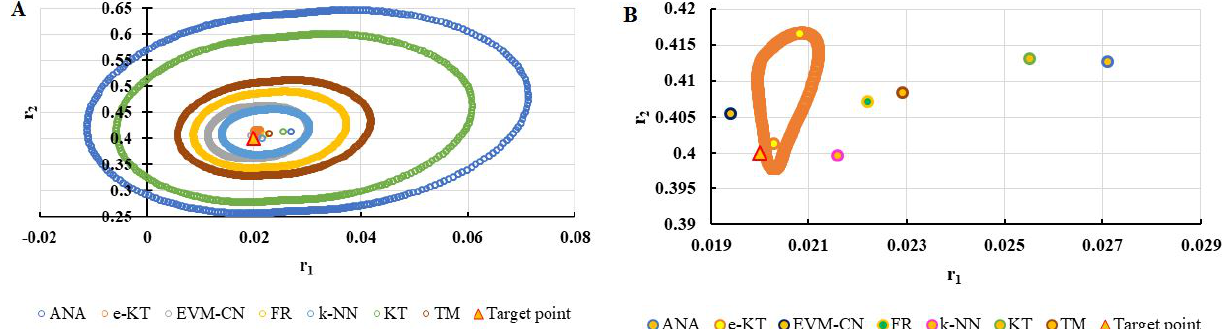
Figure 10. The JCR of analyzed methods for reactivity ratios calculation for LC1 imposed condition ( A ) and detail of smallest JCR with distribution of reactivity ratios ( B ).